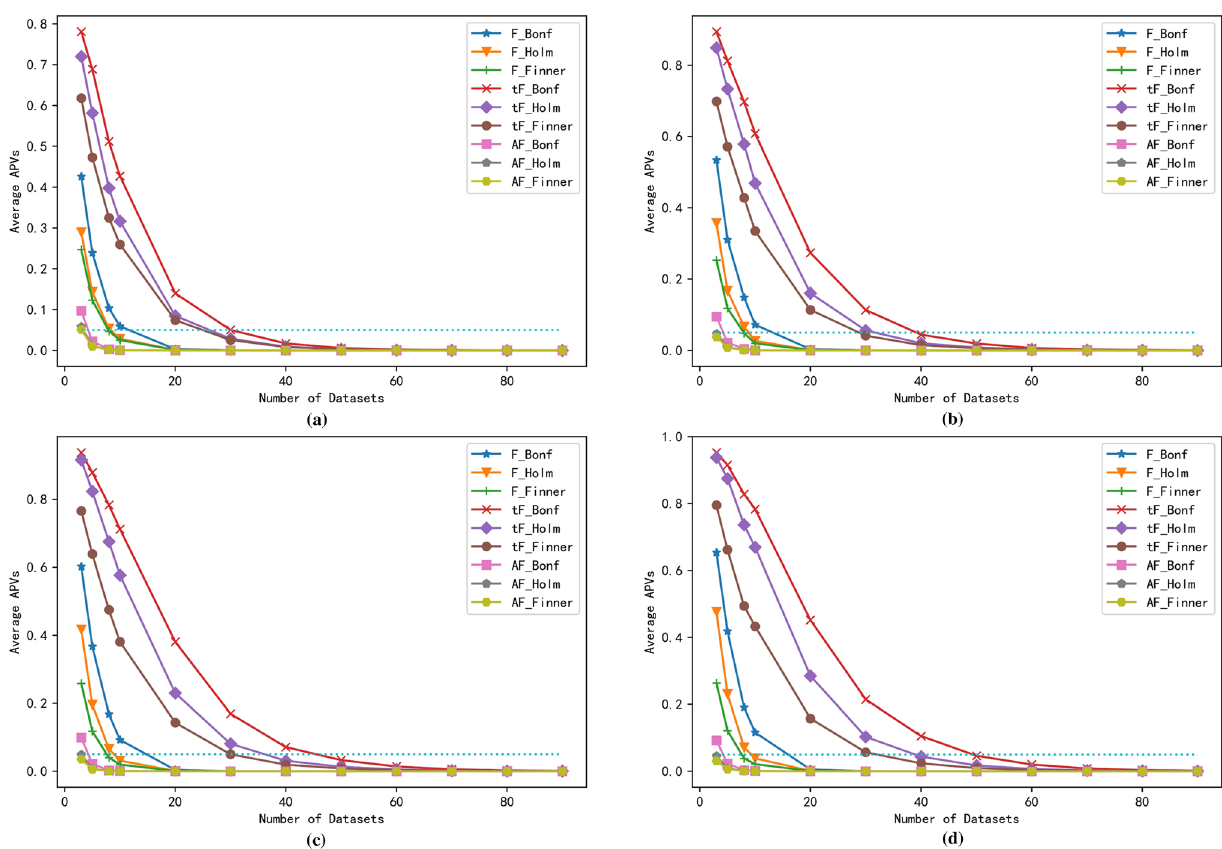
Fig. 5 Average APVs of different nonparametric statistical tests under the experiment setting v: a the number of algorithms K = 4; b K = 6; c K = 8; d K = Fig. 6 Average APVs of t-Friedman test with different significance level of t test under the experiment setting ix, the number of algorithms K = 6